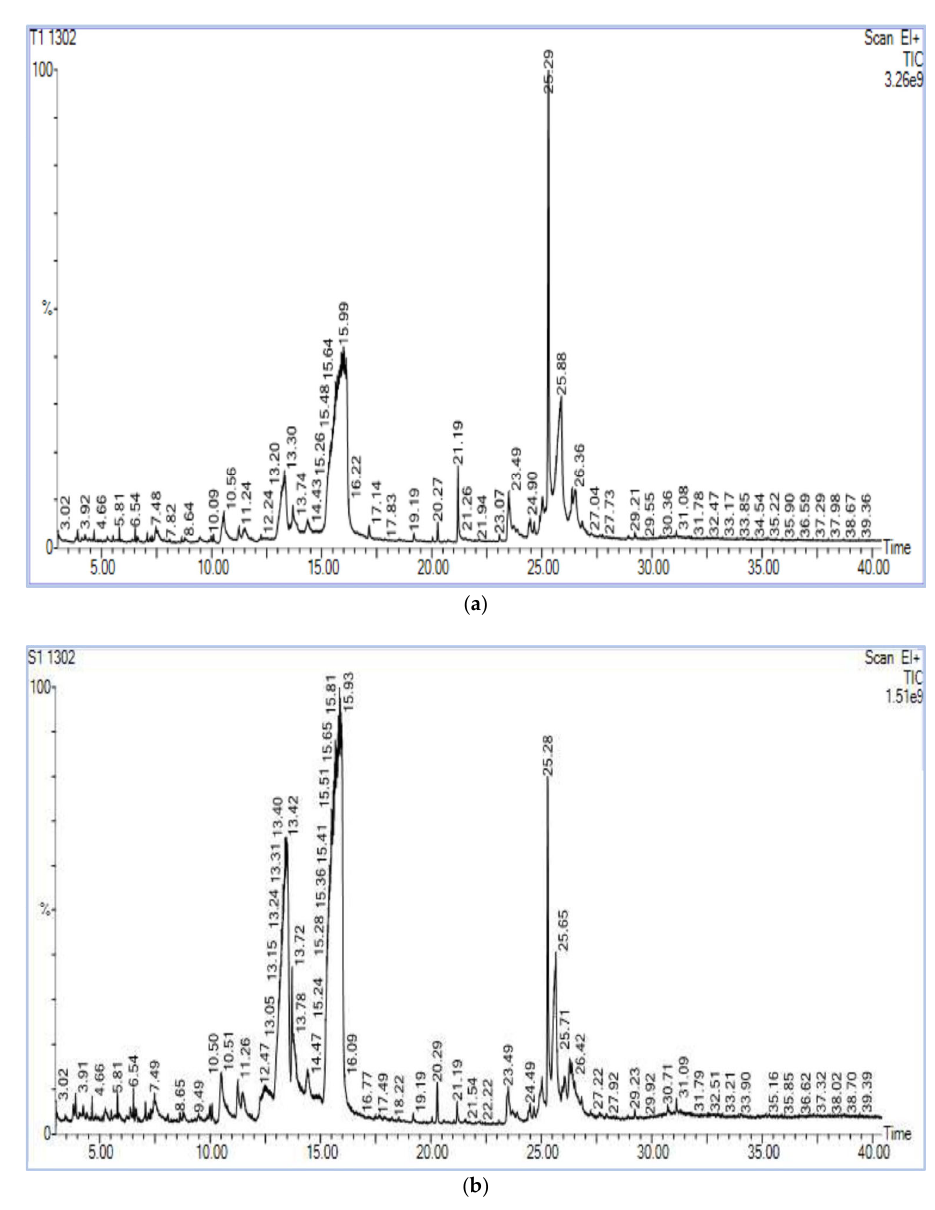
Figure 3. ( a ) Chromatogram of methanol extract of HgYMV highly resistant genotype. ( b ) Chro- matogram of methanol extract of HgYMV highly susceptible genotype.